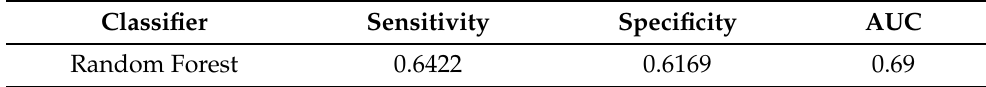
Table 7. Performance metrics of RF